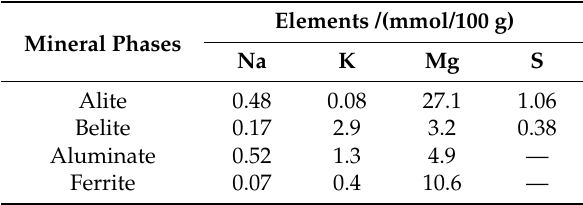
Table 2. Trace elements adopted in main clinker phases